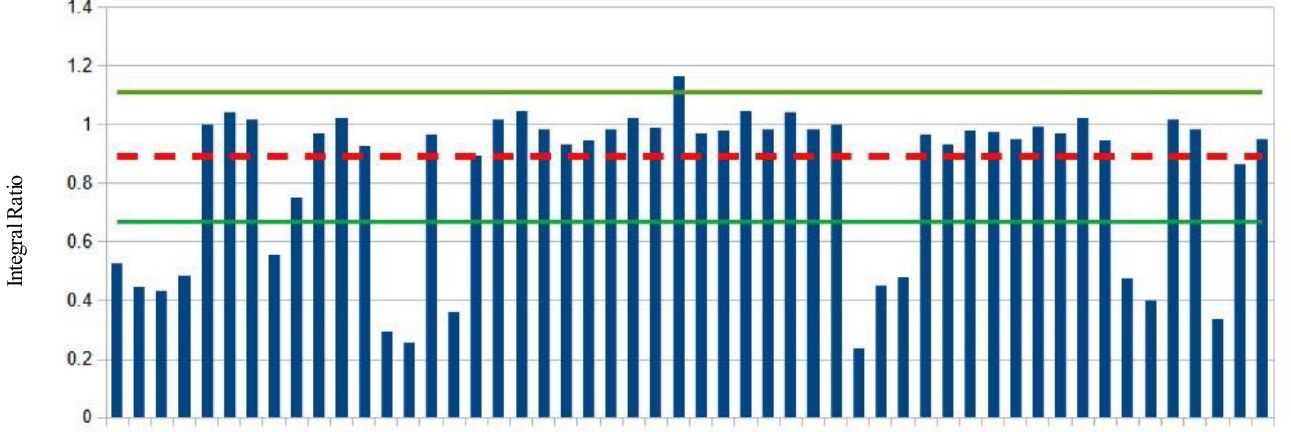
Figure 5. ω -3 Methyl protons to glycerol C2 proton ratio of the market survey samples. The mean ratio of baseline samples is depicted with a dashed red line, green lines are the mean plus or minus two standard deviations.